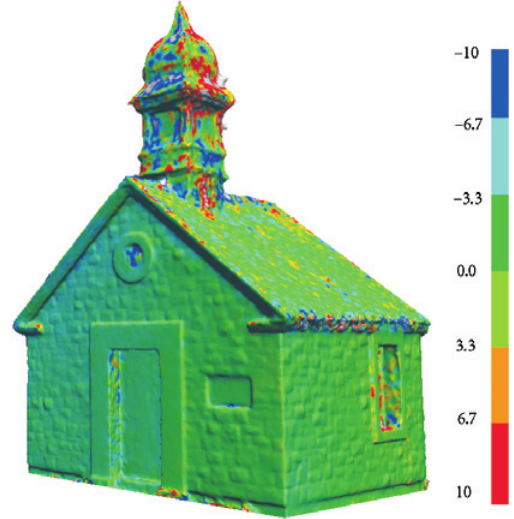
Fig. 6. A comparison between optimized 3D models with automatic calibration parameters and Photomodeler 6.2 calibration (differential scale in